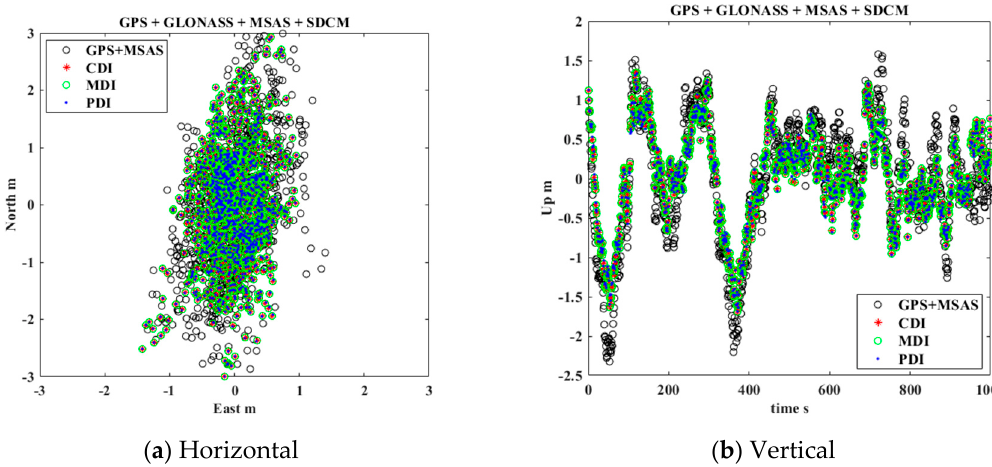
Figure 9. Estimated position errors using CDI, MDI, and PDI for multi-GNSS and multi-SBAS Table 1. Standard deviation of CDI, MDI, and PDI for single GNSS and multi-SBAS integration. Standard Deviation [m]